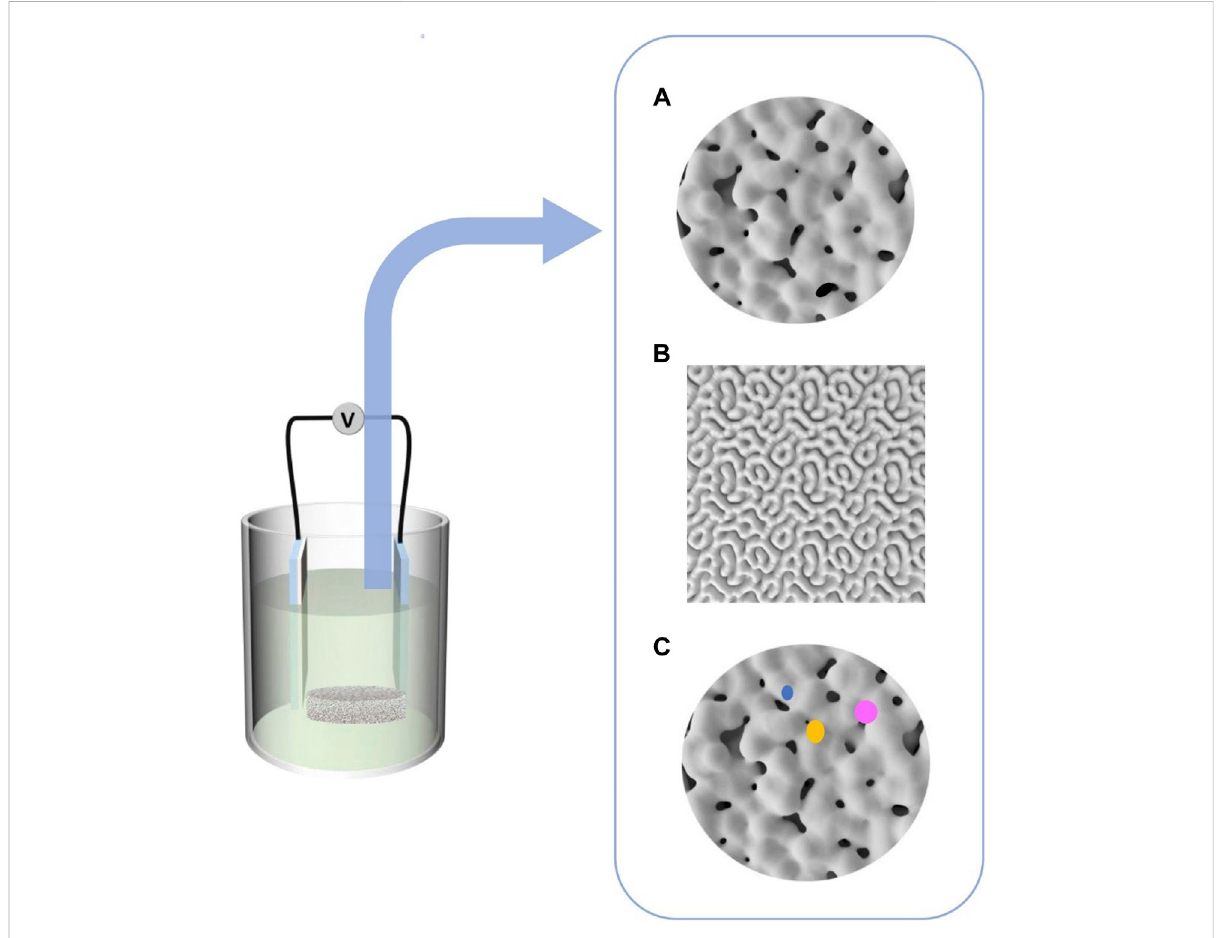
FIGURE 1 Different coating morphologies were formed by micro-arc oxidation, (A) Micropores of unequal size, (B) Cortex-like structure, (C) Bioactive ions coatings